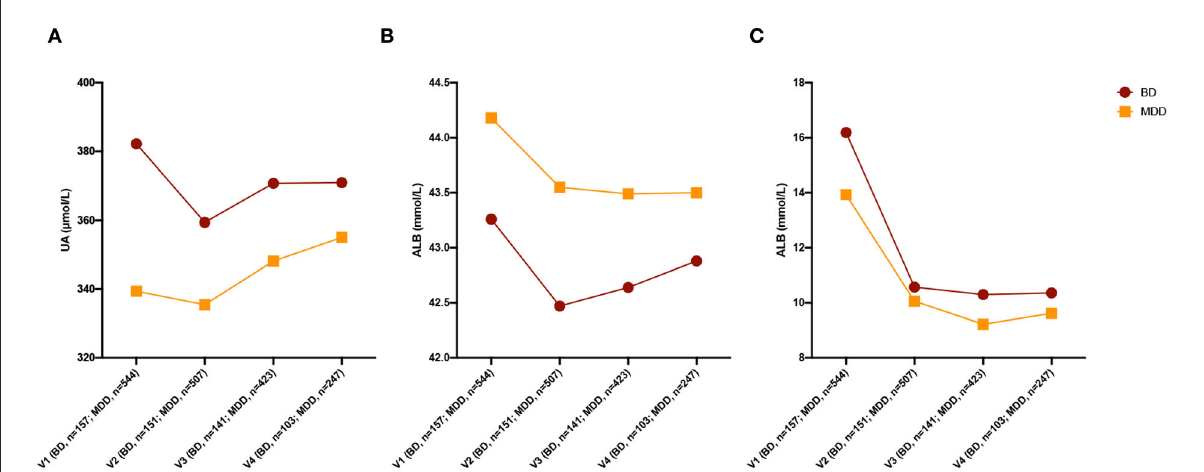
FIGURE2 Changing of three non-enzymatic antioxidants after treatment. (A) Changing of UA levels after treatment. (B) Changing of ALB levels after treatment. (C) Changing of TBIL levels after treatment. UA, uric acid; ALB, albumin; TBIL, total bilirubin; BD, bipolar disorder; MDD, major depressive disorder; HC, healthy control.